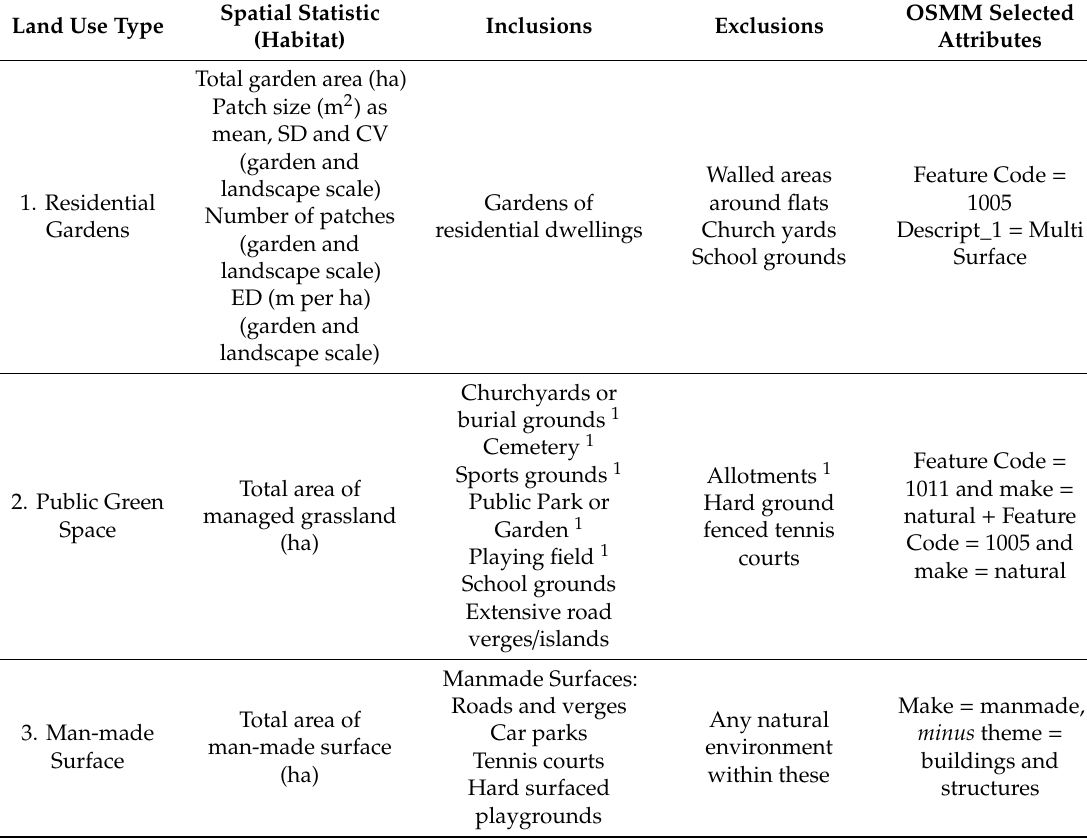
Table 1. Land use types, attributes from Ordnance Survey Master Map (OSMM) used for selecting features and spatial statistics (habitats) derived from survey areas in Brighton and Hove for identifying landscape determinants of focal activity in urban foxes ( Vulpes vulpes ). 1 Derived from Ordnance Survey Open Greenspace